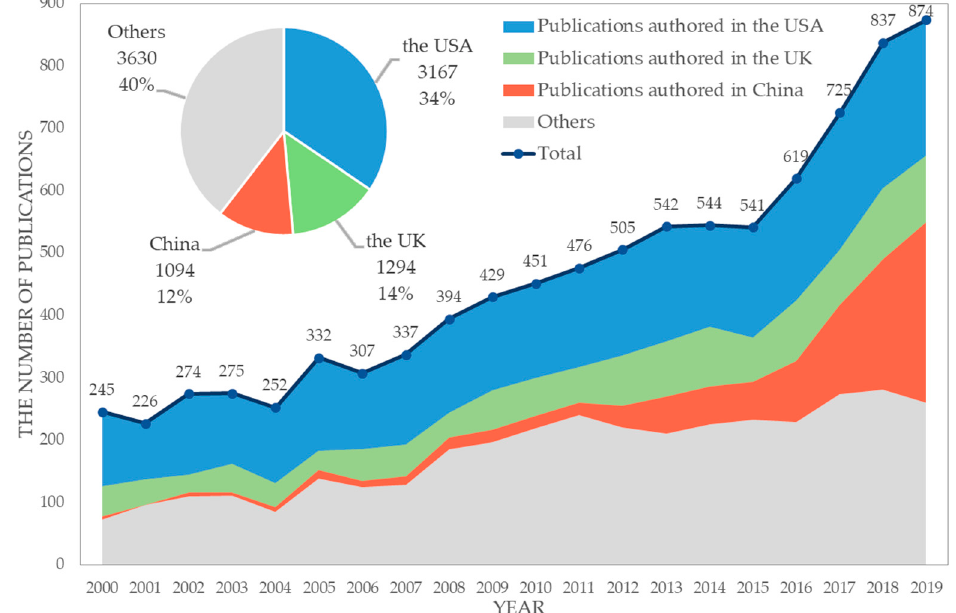
Figure 4. Temporal and international distribution of academic publications on environment regulation from 2000 to 2019.